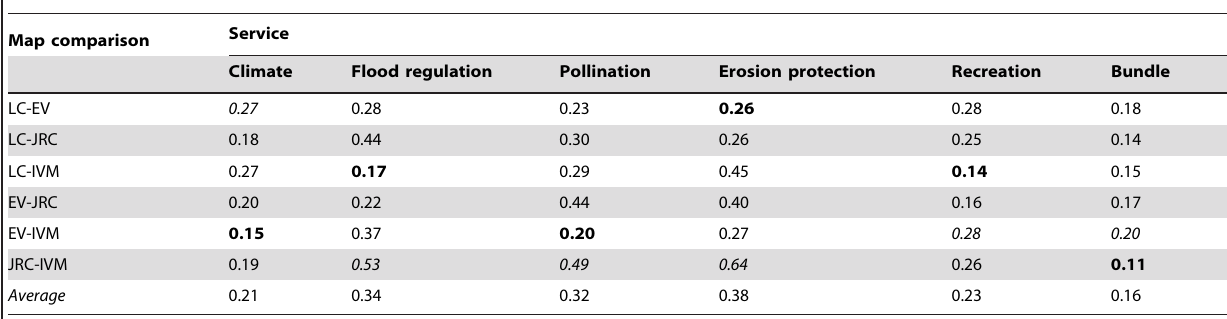
Table 2. Map comparison statistics of individual ecosystem services and bundles.